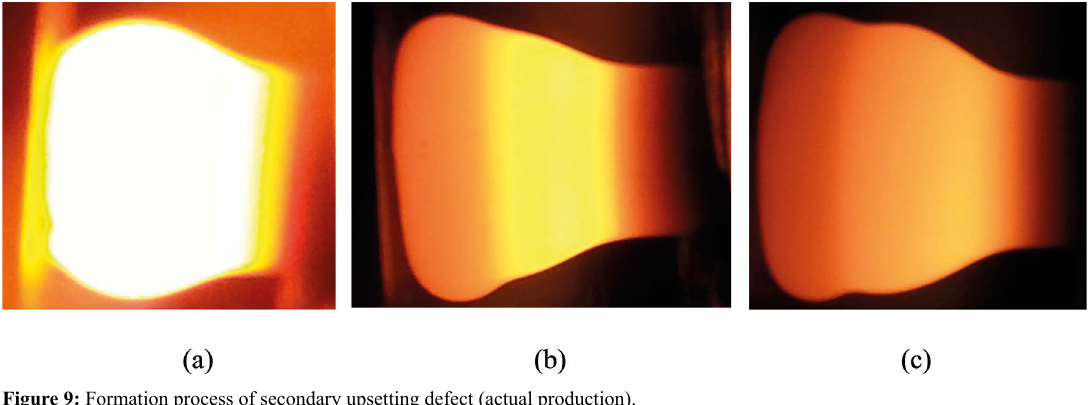
Figure 9: Formation process of secondary upsetting defect (actual production).